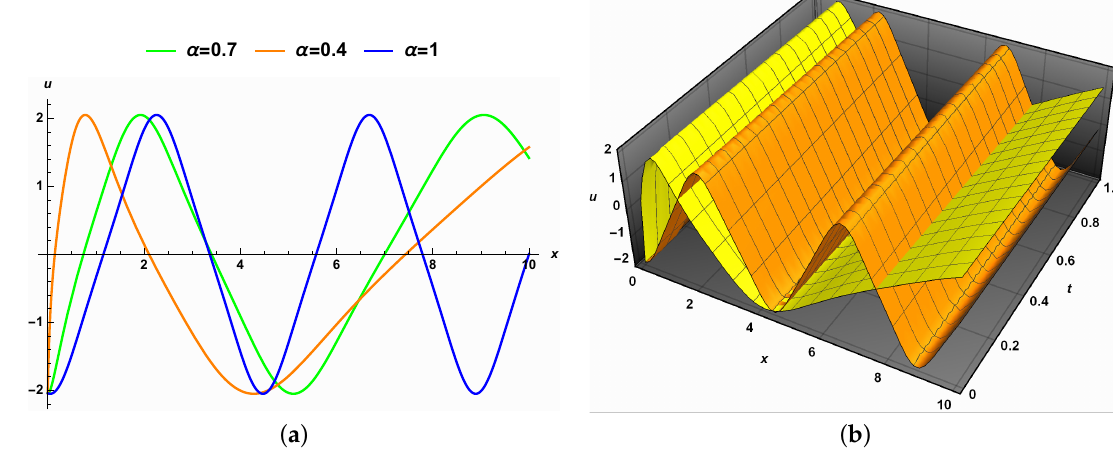
Figure 4. The effect of the fractional order α on the solution (19) when σ =